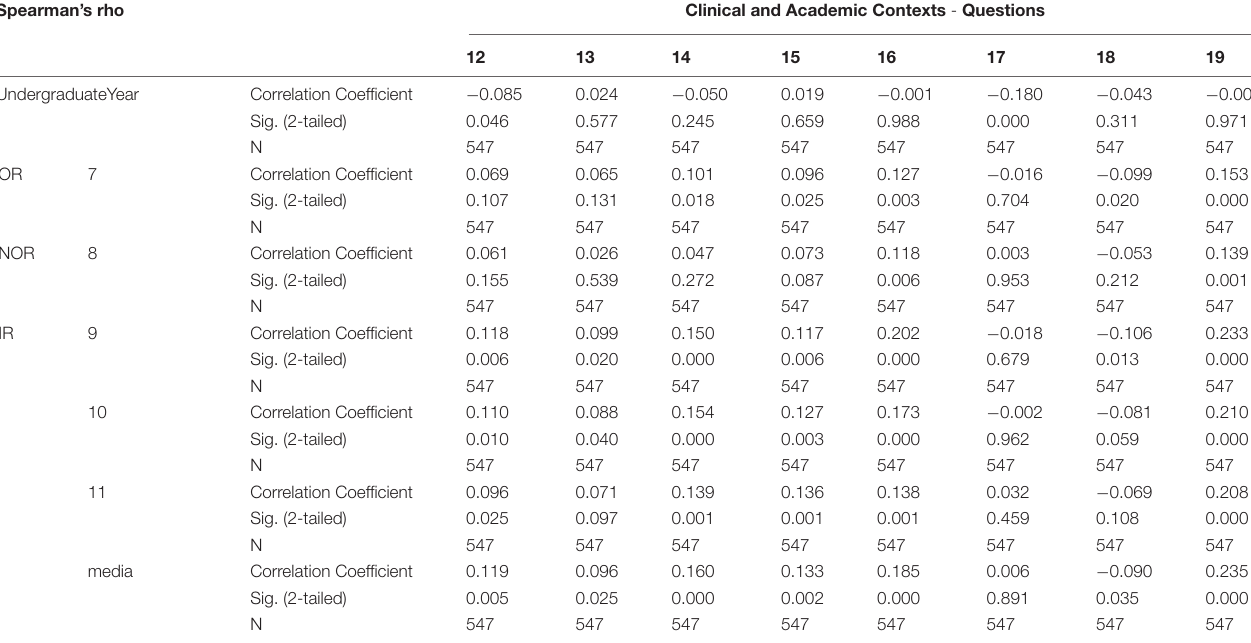
TABLE 13 | Spearman coefficient (s) – undergraduate year/DUREL and clinical/academic contexts. Spearman’s rho Clinical and Academic Contexts -